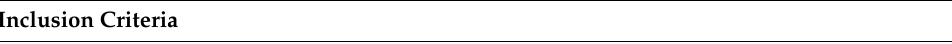
Table 1. Inclusion